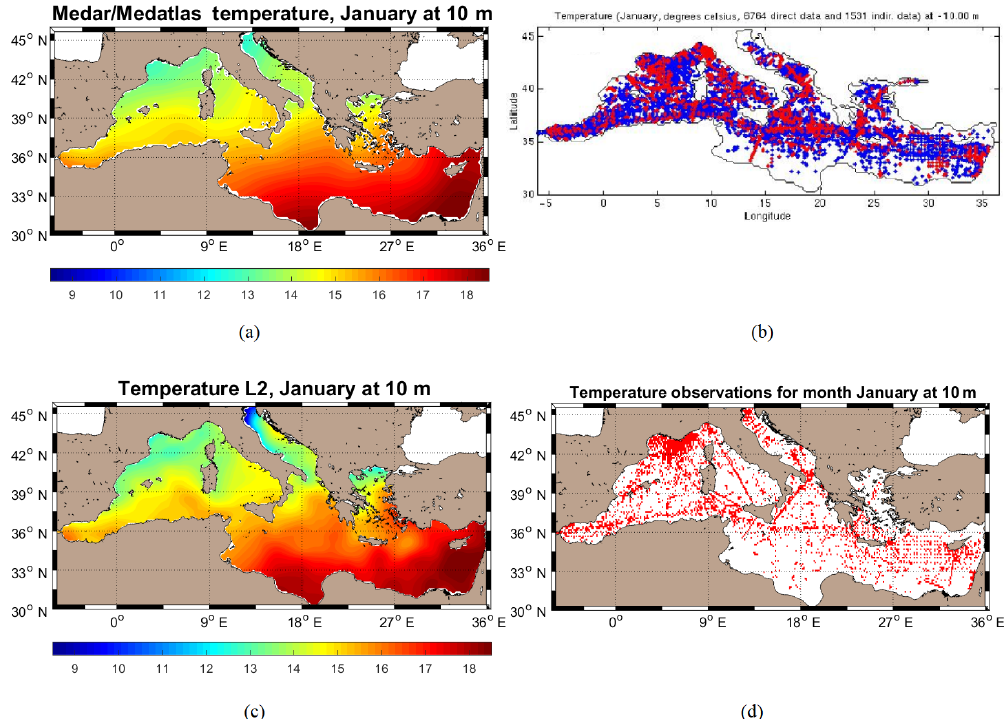
Figure 13. January temperature at 10m: (a) Medar/Medatlas, coastal data removed from the analysis; (b) data used (imported from http:// modb.oce.ulg.ac.be/backup/medar/JPGSTATIONS/medar.01.med.temp.23.3.0.stations.jpg, last access: 9 July 2018); (c) current climatology, coastal data included; (d) data used.